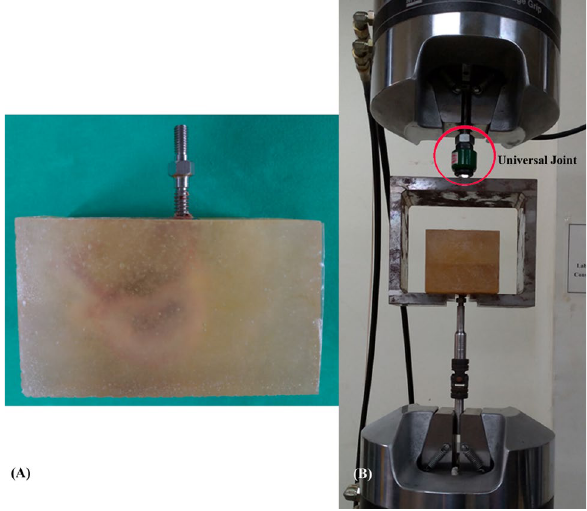
Figure 9. Photographs of a cubic specimen embedded in acrylic mixture ( A ), and the screw pullout test performed by MTS testing machine ( B ). The custom-designed universal joint with a self-aligning function to ensure vertical pullout measurement is